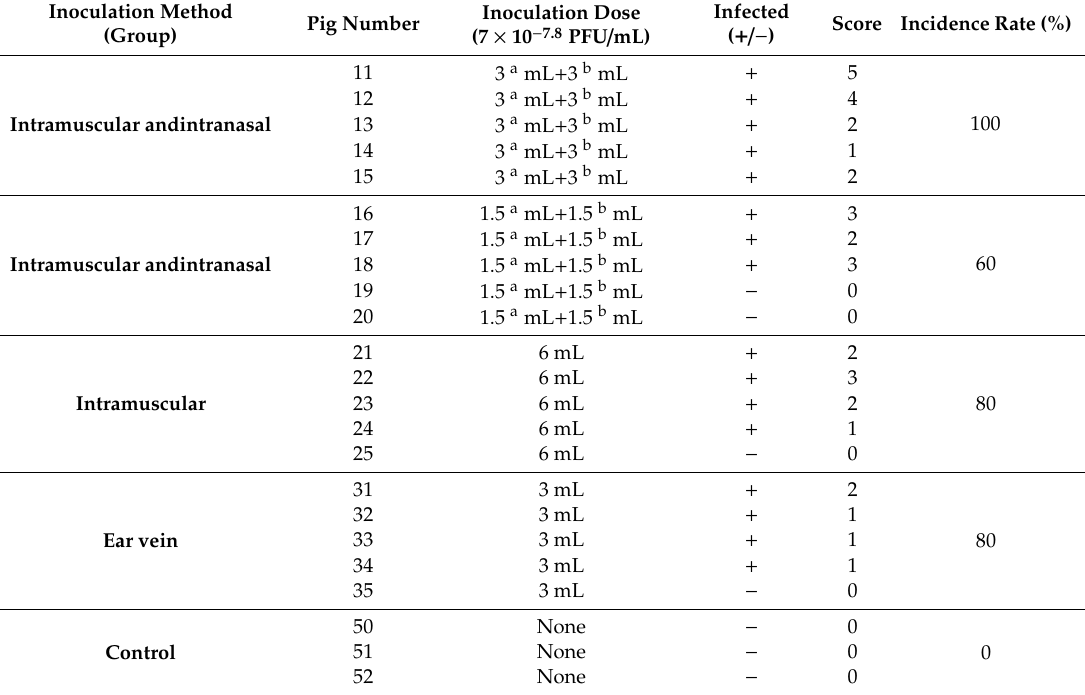
Table 1. SVA CH-HB-2017-strain-infected minimum dose exploration.